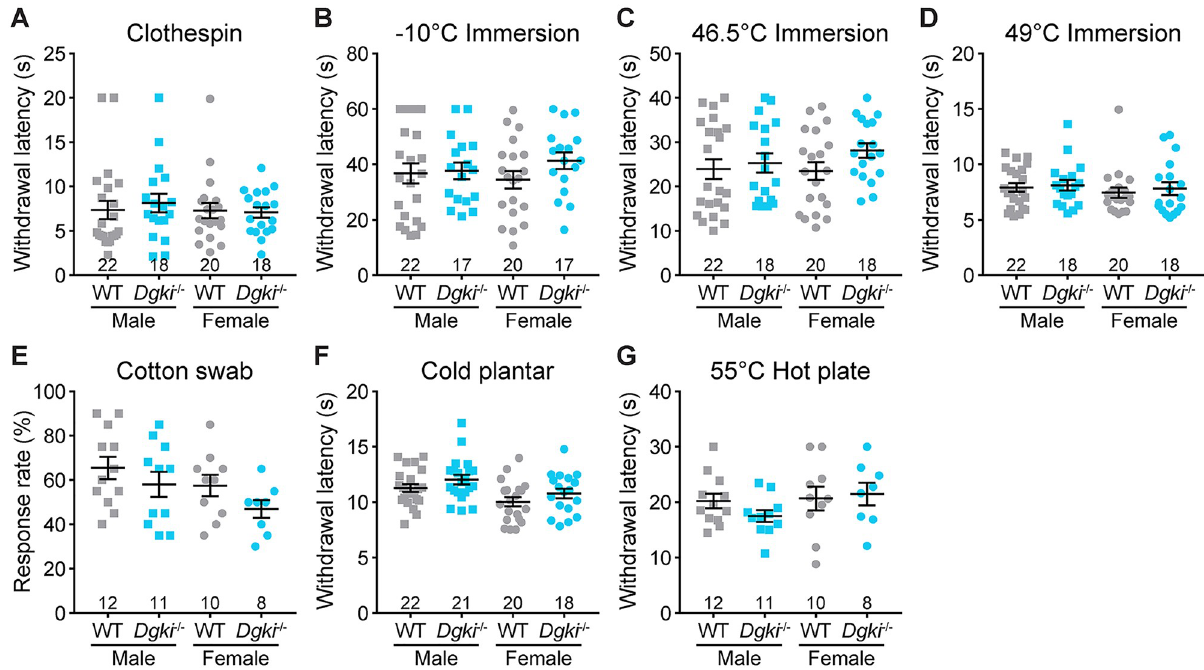
Fig 3. Loss of Dgki does not affect acute nociception in mice. (A) The latency to respond to a miniature clothespin attached to the tail. B-D) The latency to respond to immersion of the tail in a bath set to a temperature of -10˚C (B), 46.5˚C (C), or 49˚C (D). E) The rate of response to a light touch with a fluffed-out cotton swab. F) The latency to withdraw the hindpaw from an application of dry ice. G) The latency to lick hindpaw or jump after placement on a 55˚C hot plate. The number of mice tested is indicated. Graphs show mean ± SEM.